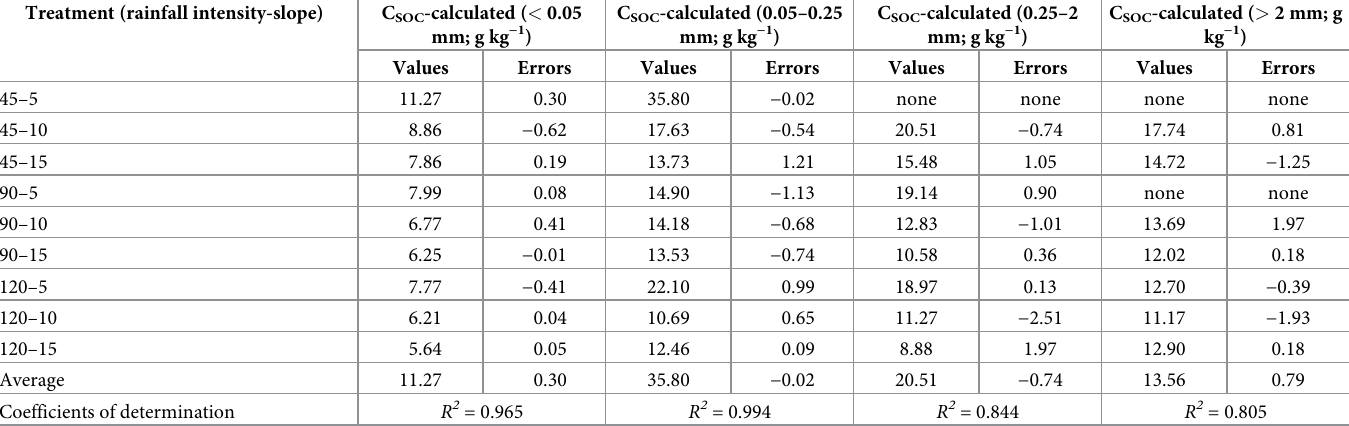
Table 6. Calculated results of the OC distribution in sediments regressed function. Treatment (rainfall intensity-slope)